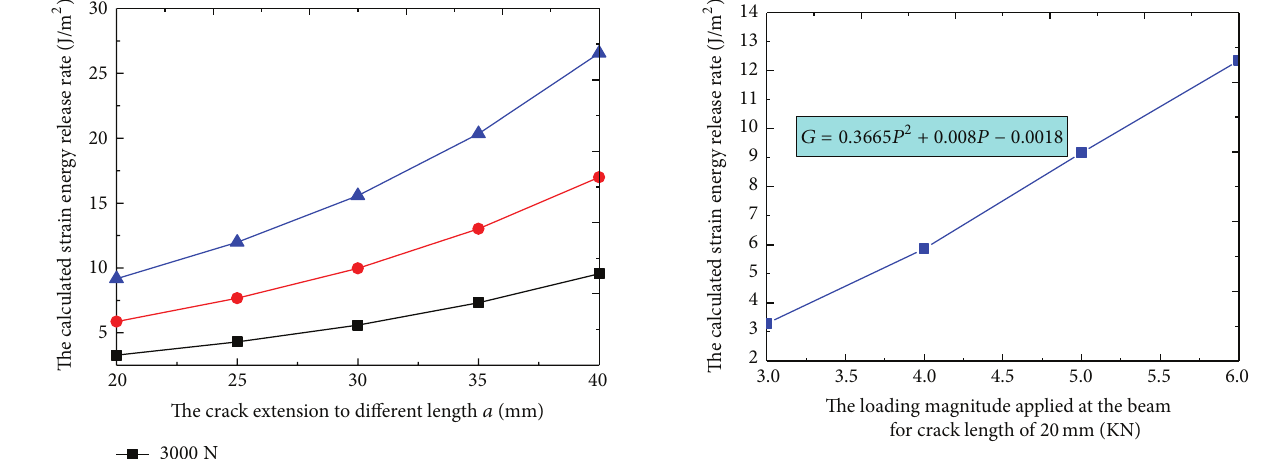
Figure 7: The calculated SERR for different load at the crack length of 20